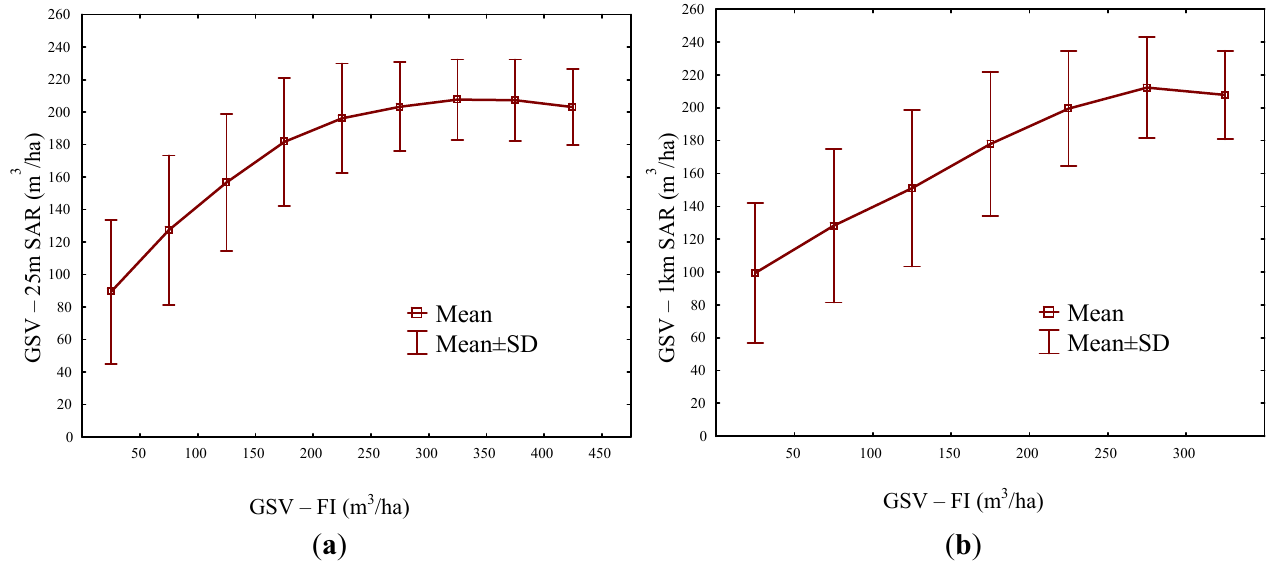
Figure 6. Correlation between growing stock volume and forest inventory and 25 m